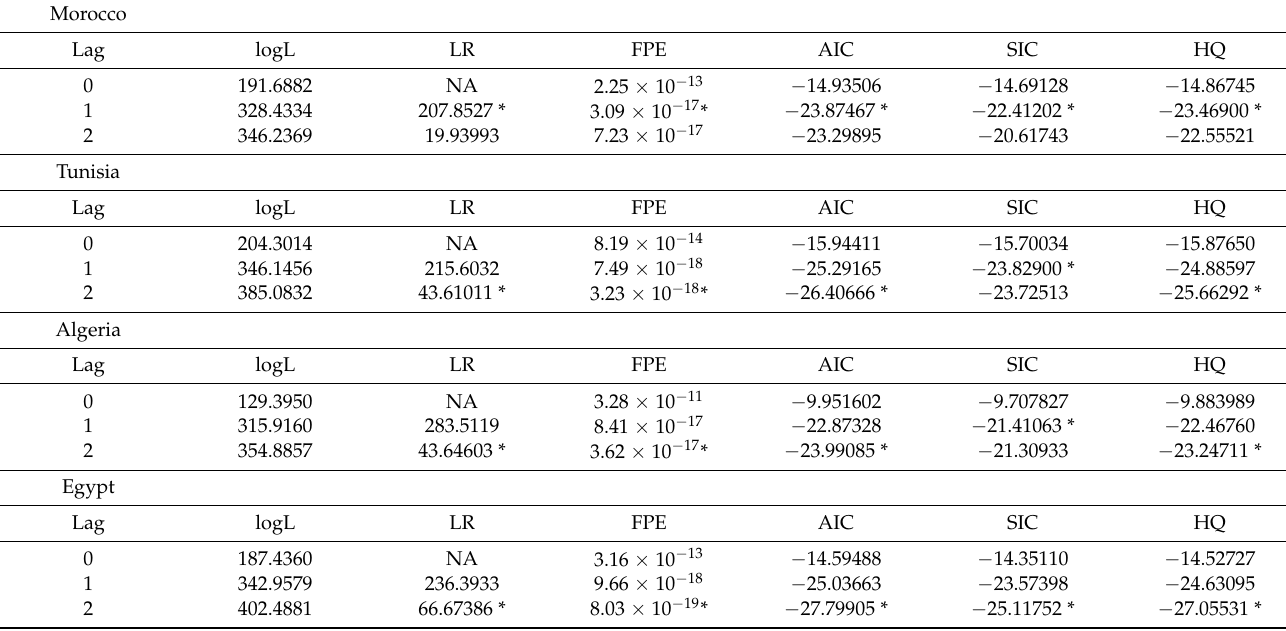
LR: sequential modified LR test statistic (each test at 5% level). FPE: Final prediction error. AIC: Akaike information criterion. SC: Schwarz information criterion. HQ: Hannan–Quin information criterion. * indicates lag order selected by the